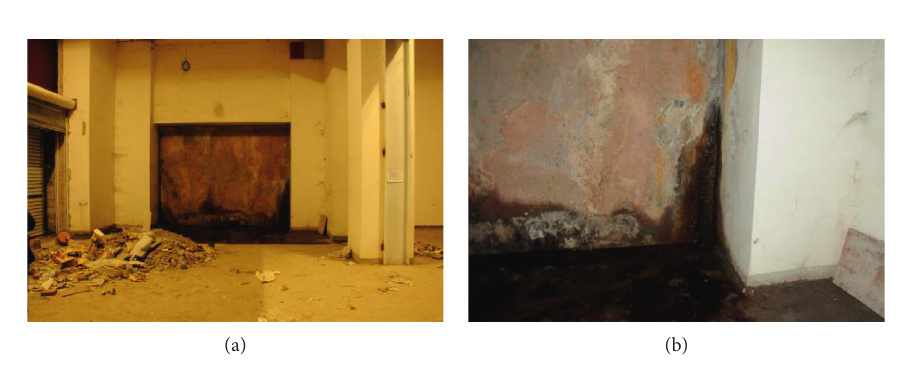
Figure 14: Water seeping inside the